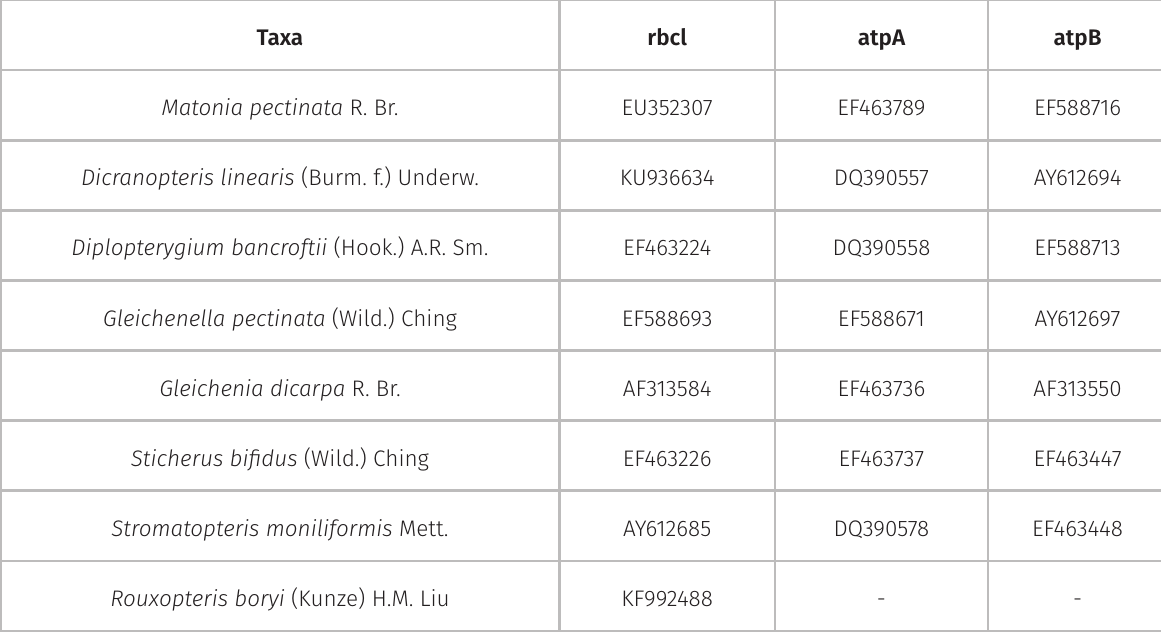
Table I. GenBank accession for phylogenetic framework.